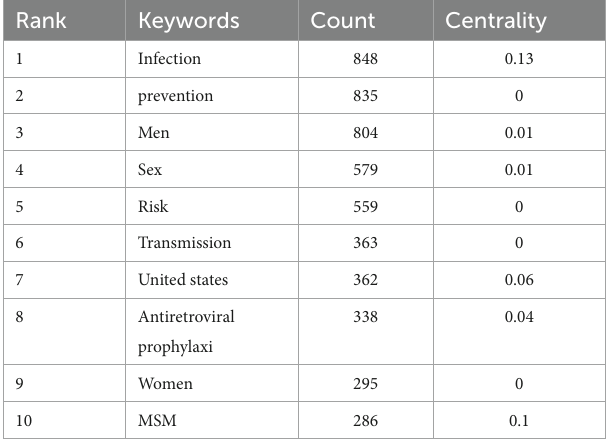
TABLE 4 The top 10 high-centrality